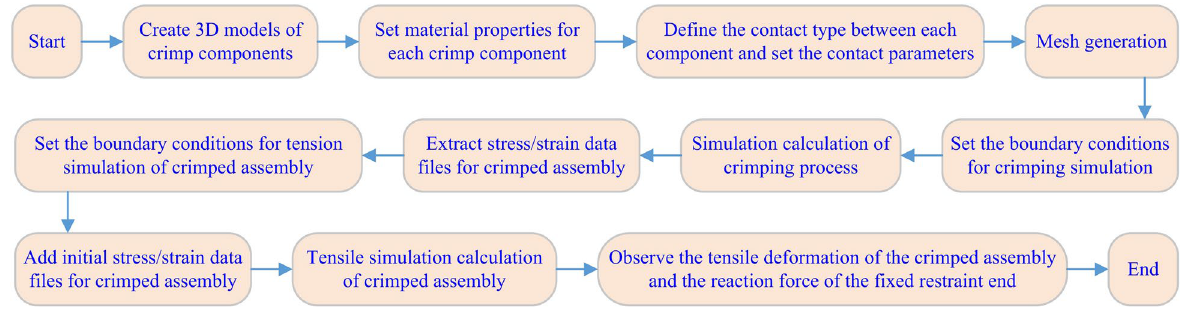
Figure 2. The flow of the overall simulation